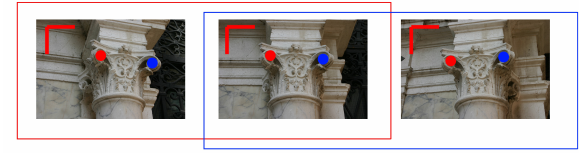
Figure 3. Formation of triples